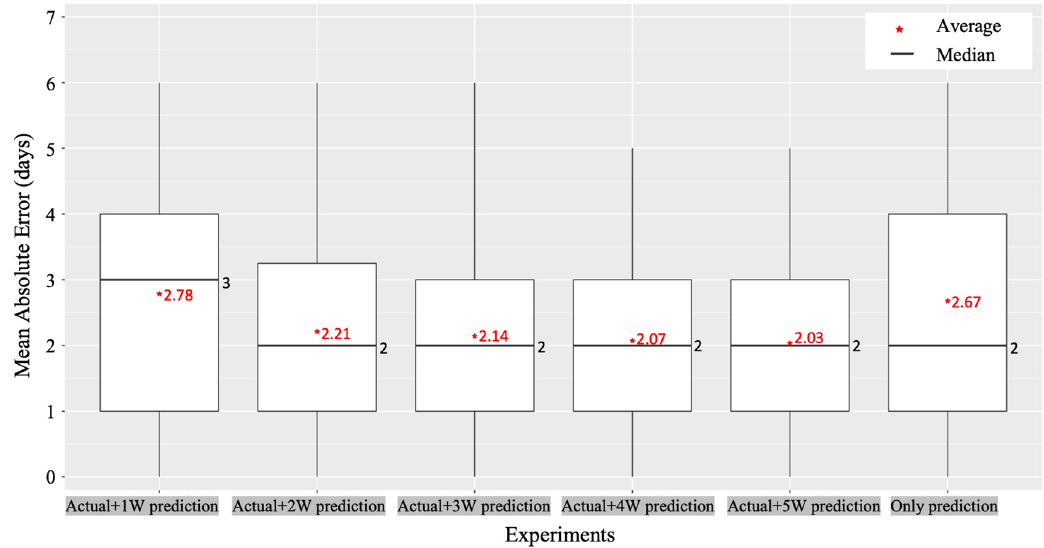
Figure 16. Average of Mean Absolute Error (MAE) between the actual harvest date and predicted harvest date.